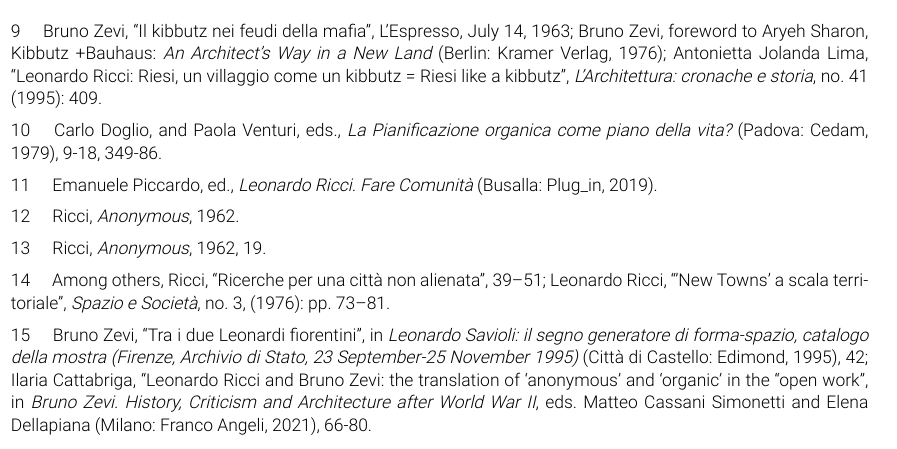
Fig. 2 Leonardo Ricci, "Theoretical House", sketch on the vertical and on the horizontal dimen- sions, images published